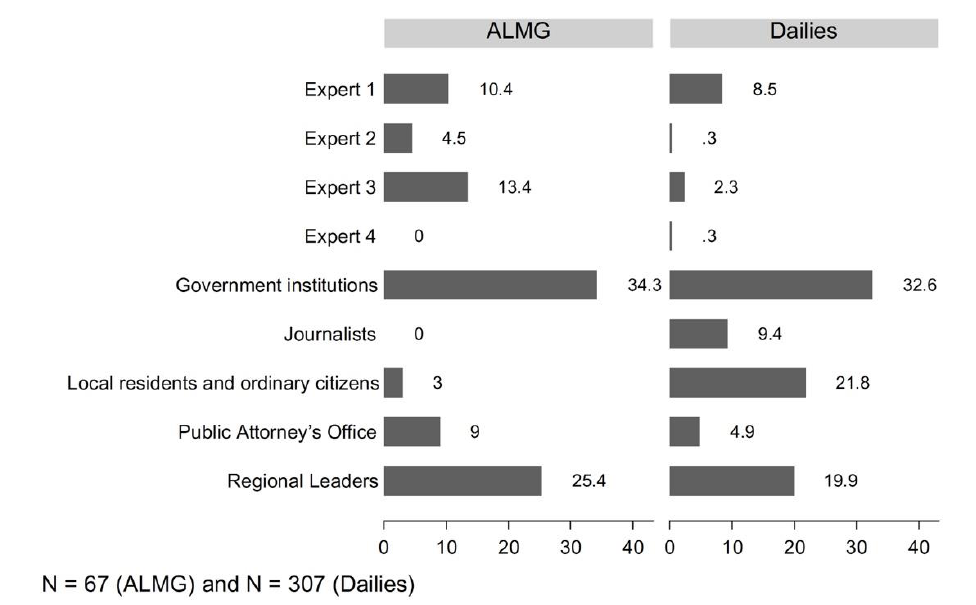
Figure 2: Positon Against and Pro the Bill of Law of all participants and